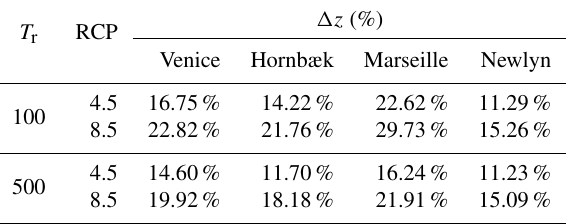
Table 4. Results of the percentage changes in total water level ( (cid:49)z ) obtained with the two future scenarios (RCP4.5 and RCP8.5) and the return periods (100 and 500 years) for the four sites under anal-